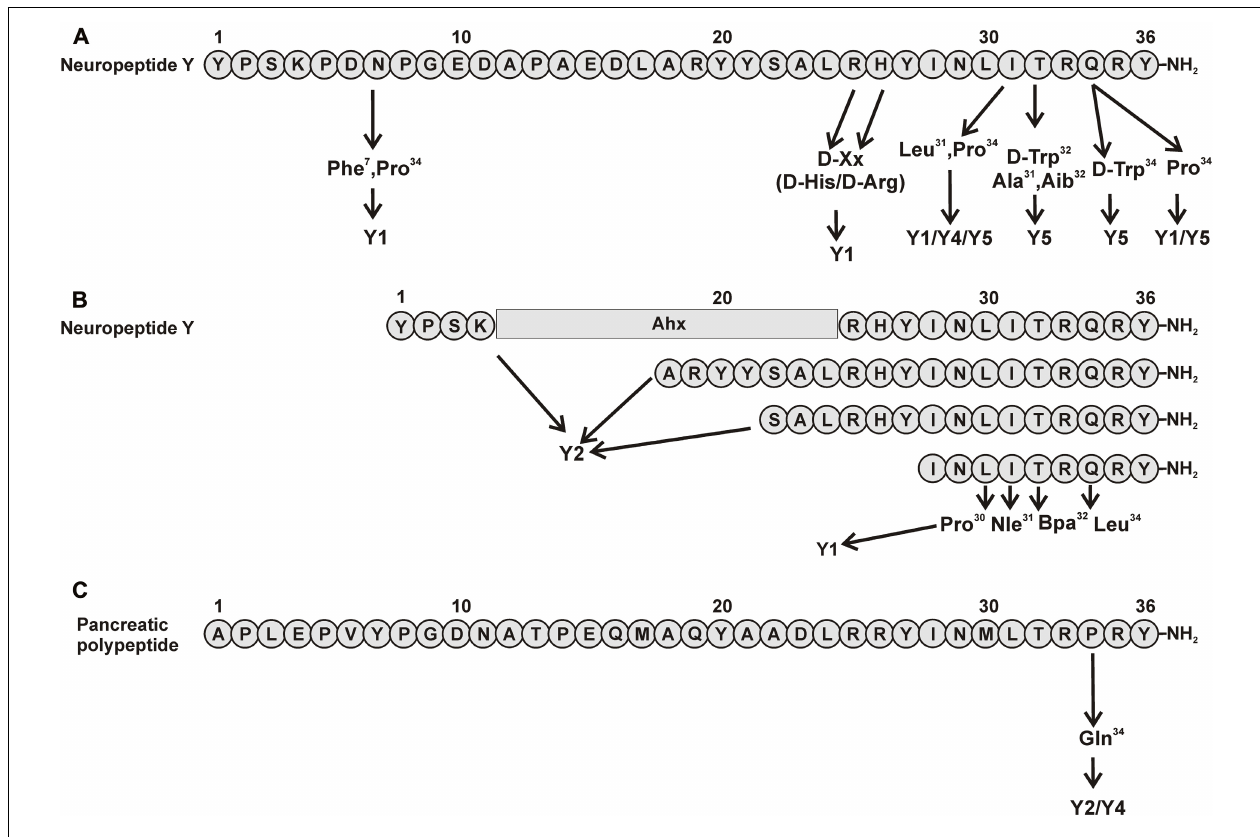
FIGURE 1 | Important amino acid positions and truncated peptides to introduce selectivity to NPY receptors. (A) Important positions in pNPY (Fuhlendorff etal., 1990; Cabrele etal., 2000, 2002; Parker etal., 2000;